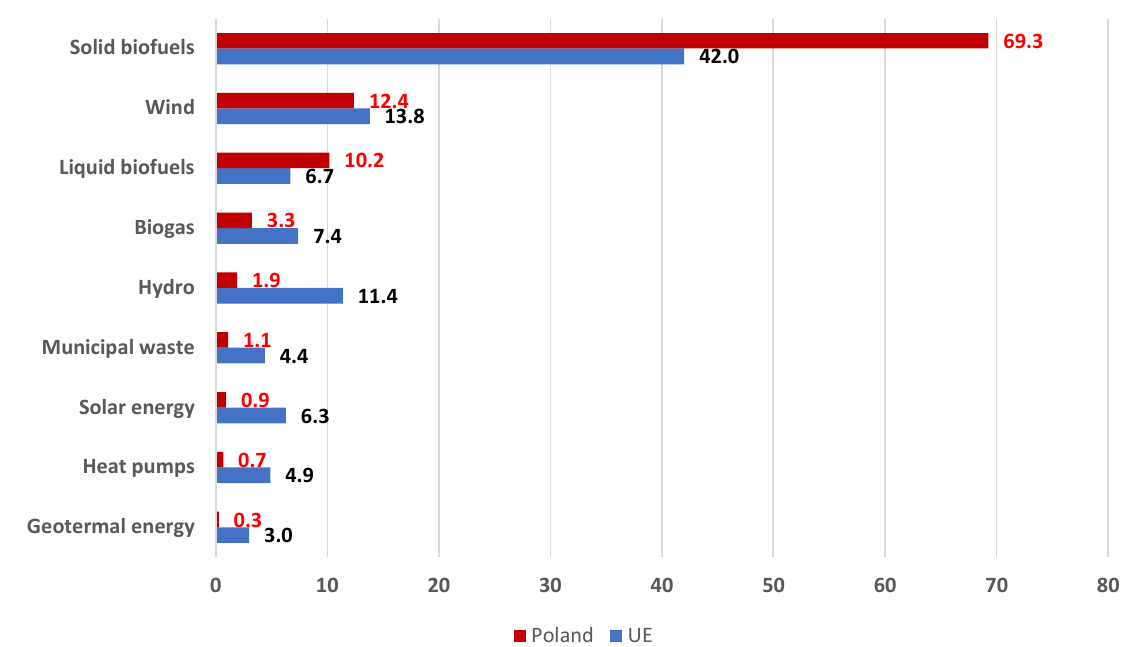
Figure 1. Total primary energy generation of renewables in EU-28 (a) and in Poland (b) (in PJ). Own study, based on [31].